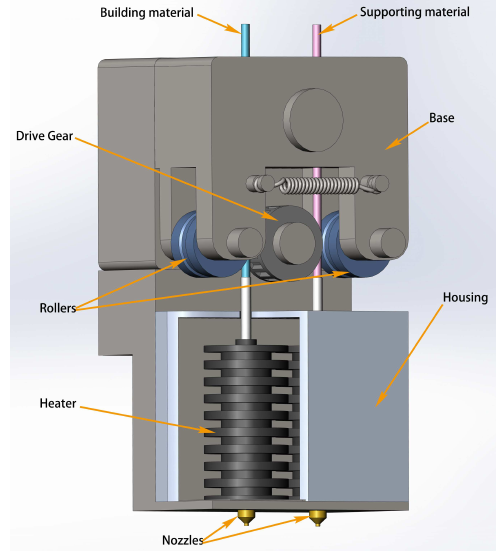
Figure 5. 3D layout of the FDM extruder.